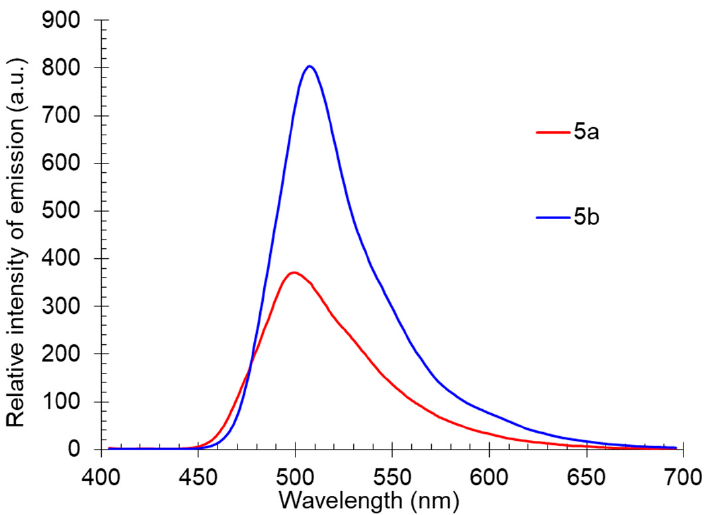
Figure 10. Solid-state photoluminescence spectra of compound 5 in a powder.